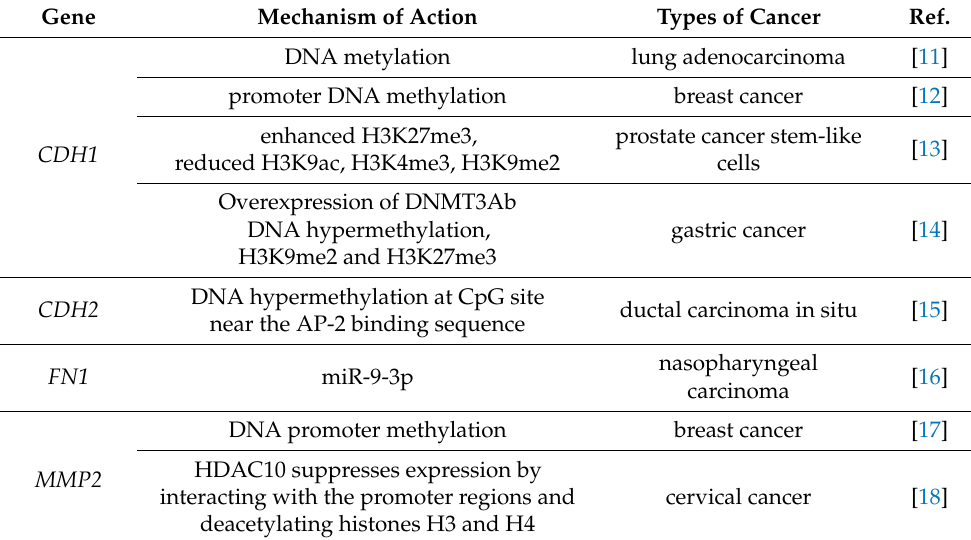
Table 1. Examples of epigenetic regulatory mechanisms of epithelial and mesenchymal